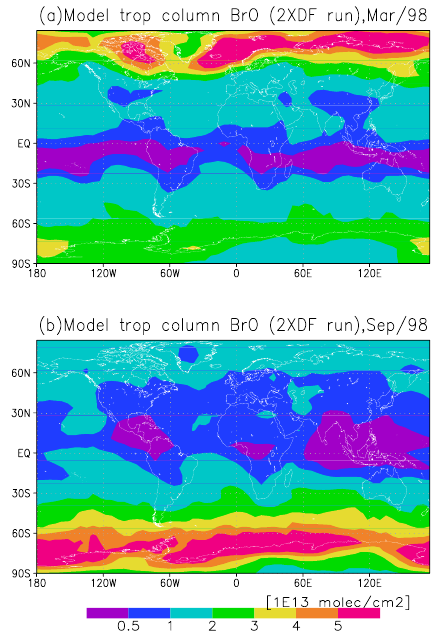
Fig. 8. Tropospheric column BrO in March (a) and Septer- ber (b) from 2XDF run. The unit of column BrO is 1 × 10 13 molecules/cm 2 .